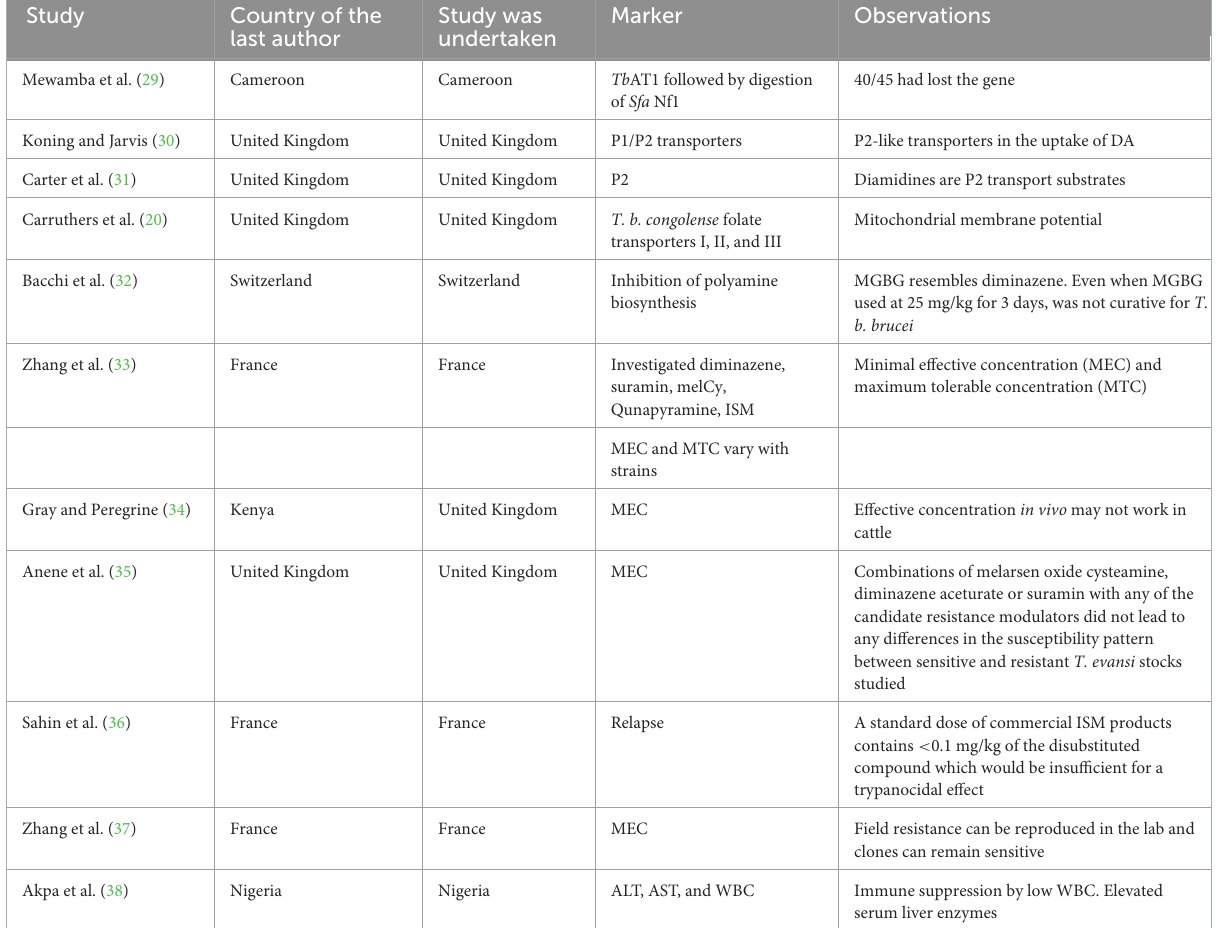
TABLE 4 Resistance markers screened in African animal trypanocide